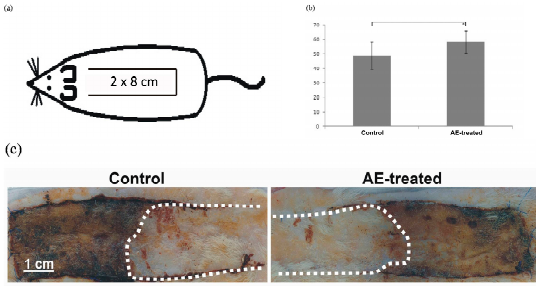
Figure 4. Skin flap in rats following Agrimonia eupatoria L. treatment; ( a ) dimensions of the skin flap located on the back of each rat s; ( b ) effect of A. eupatoria on skin flap viability expressed in percentages (* p < 0.05); and ( c ) photograph showing skin flaps of control and treated rats seven days after surgery (the dotted line labels vital part of the flap).